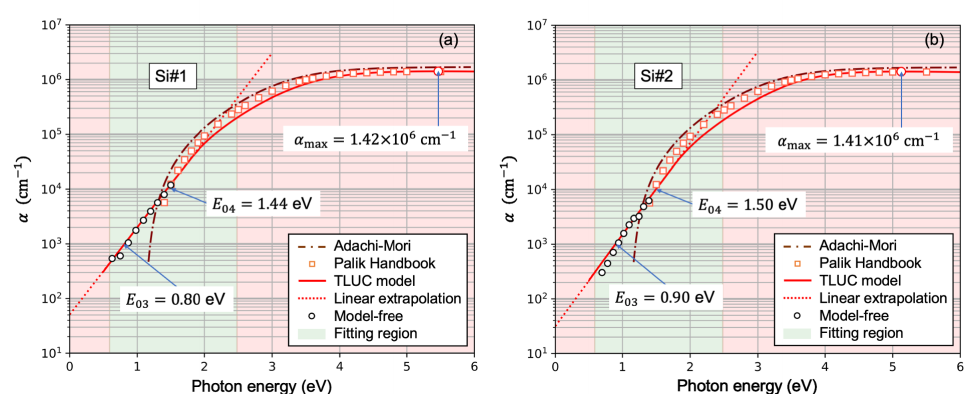
Figure 7. Spectral dependence of the logarithm of the absorption coefficient (that is, the optical- absorption edge), for the two RFMS- a -Si thin layers; ( a ) Si#1 and ( b ) Si#2. The values of the two iso- absorption gaps, E 03 and E 04 , are both conveniently marked in the corresponding absorption spectra.